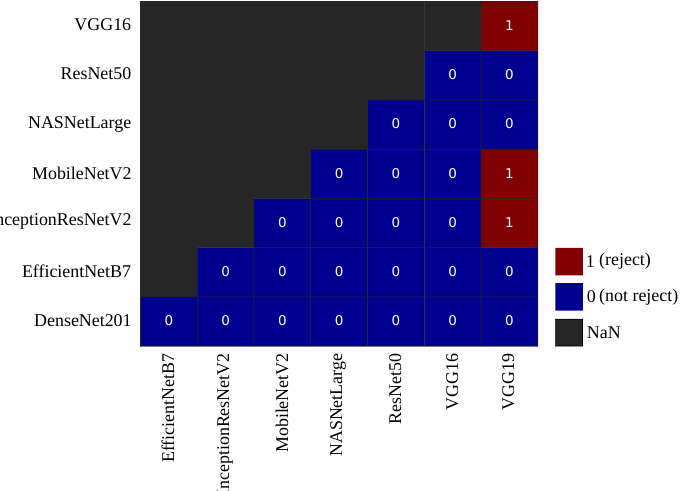
Figure 8. Comparison matrix of the DCNN models at the 5% significance level by performing t-tests. Further analysis of the training execution time of the pre-trained models was per- formed. The results indicated that although all the pre-trained models performed with the same accuracy, the MobileNetV2 architecture outperformed dramatically in terms of the training speed and fast convergence. Table 3 lists the execution times of the training processes obtained for each model. Each model was trained using 240 patients’ input images (each patient had HEX and FAM images), and the current model was validated using 160 unseen patient data during a total of 100 training epochs, which resulted in the total execution time of the models. Table 3. Total training execution time of the pre-trained models on the PCR COVID-19 dataset.